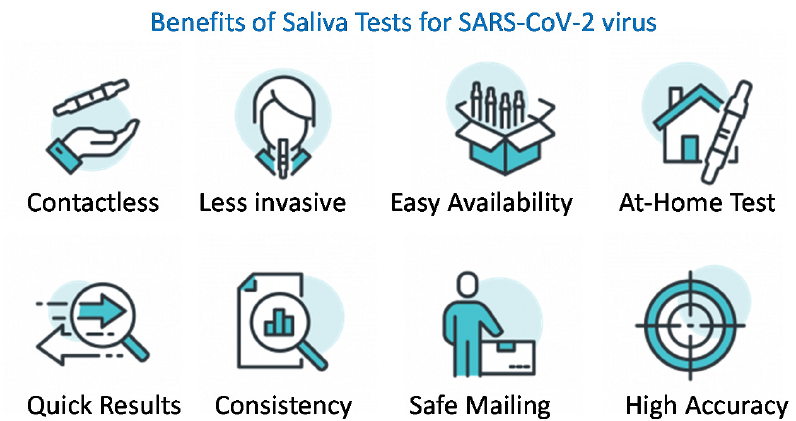
Figure 6. Benefits of using saliva specimens for SARS-CoV-2 detection compared to respiratory specimens. Images are reproduced and adapted with permission from IBX Infinity Biologix [26].